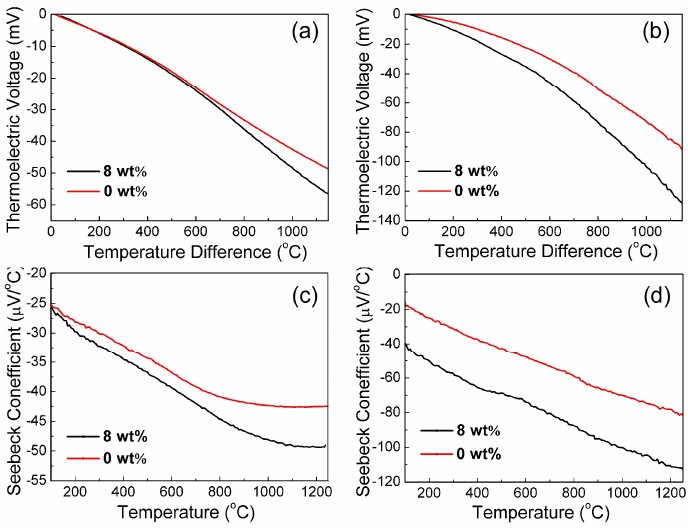
Figure 4. Thermoelectric properties of ITO and In 2 O 3 films: ( a , c ) ITO film; ( b , d ) In 2 O 3 film.